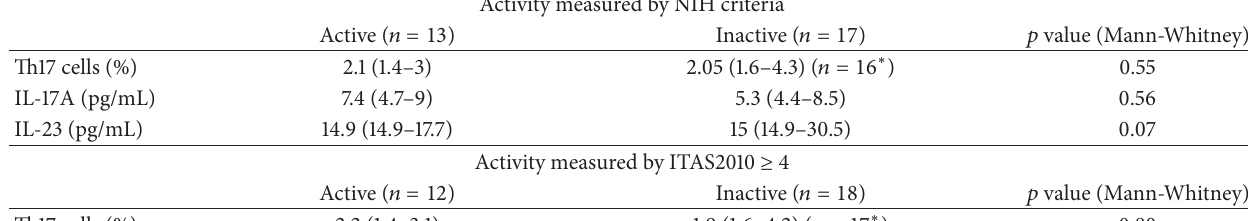
Table 2: Th17 cells, serum IL-17, and IL-23 levels with respect to disease activity parameters and immunosuppressants. Activity measured by NIH